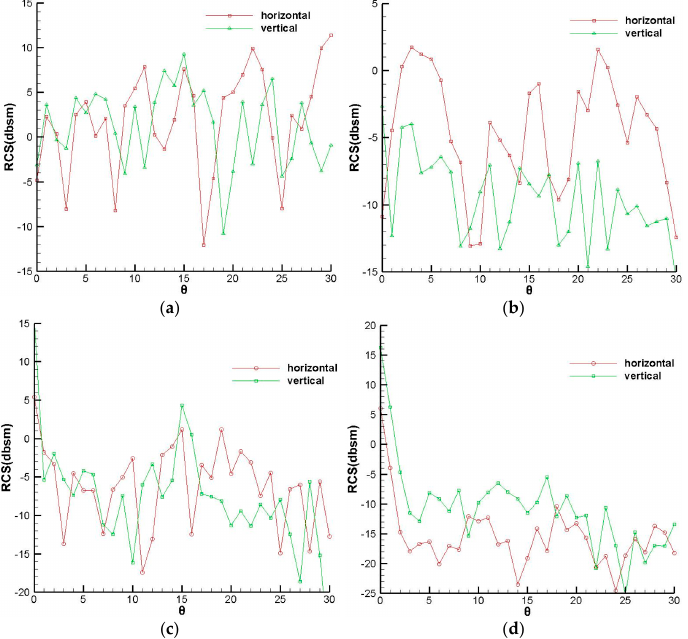
Figure 20. RCS of inlet coated with low scattering material. ( a ) Vertical detection-3GHz ( b ) Horizontal detection-3GHz ( c ) Vertical detection-10GHz ( d ) Horizontal detection-10GHz. Table 12. Statistics of RCS (dbsm) at various conditions.